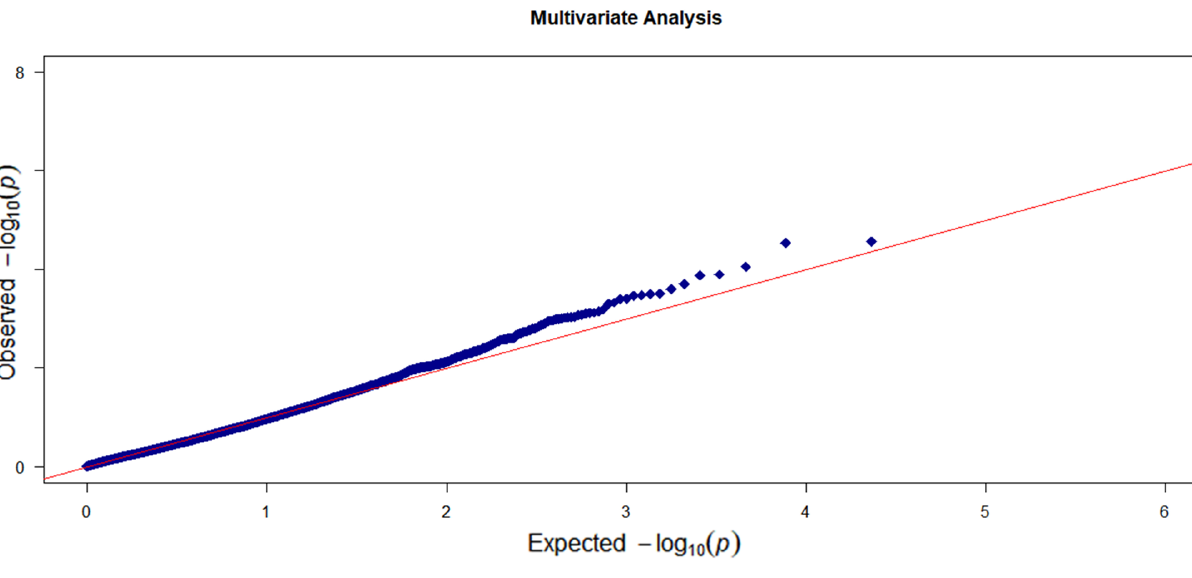
Frontiers in Genetics |